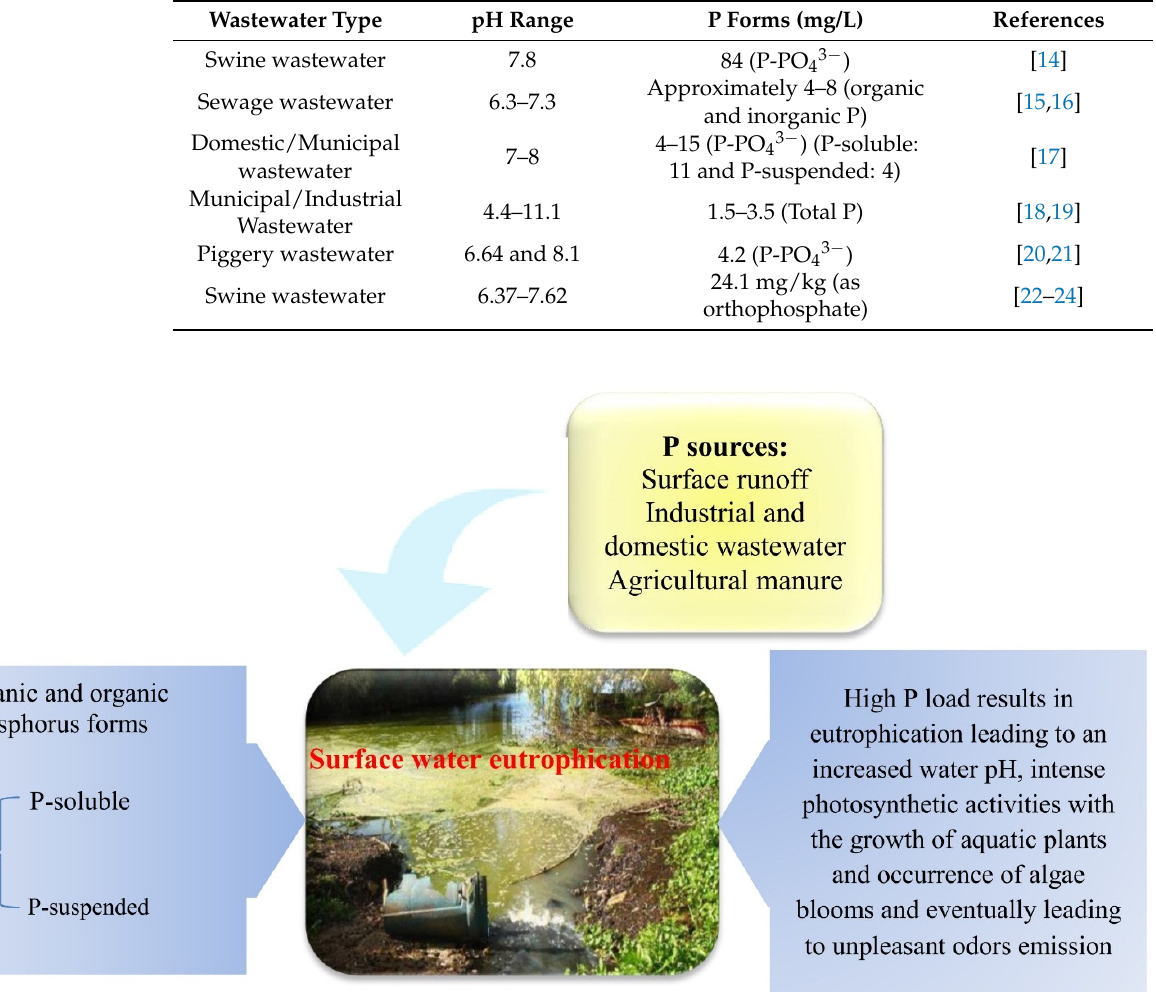
Table 1. Wastewater types with their pH and phosphorus concentration.